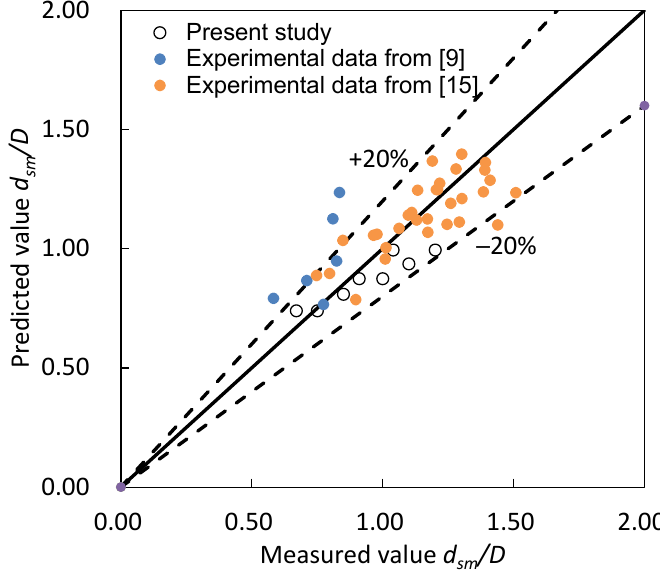
Figure 13. Comparisons of measured and predicted scour depth using Equation (5).